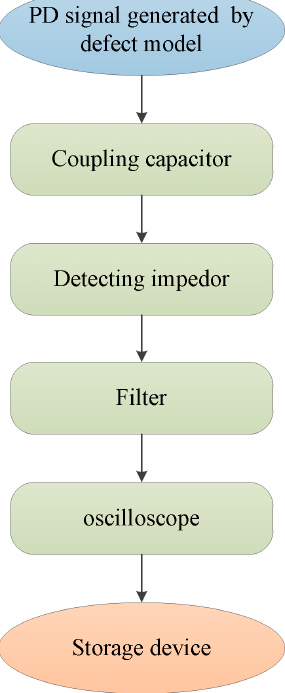
Figure 4. Flow diagram of the PD measurement.